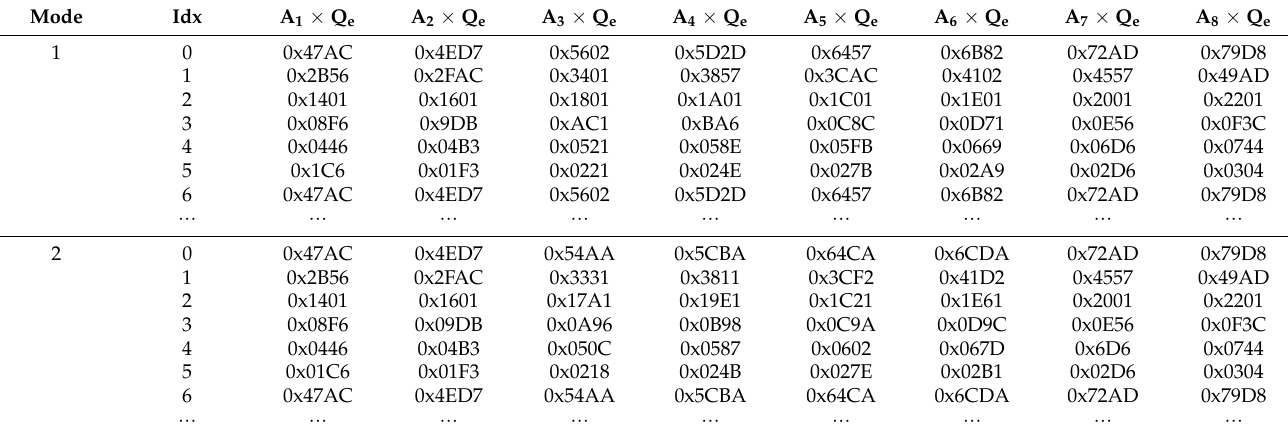
Table 10. A i Q e lookup table (Mode-1,2, 47 × 8, α = β =